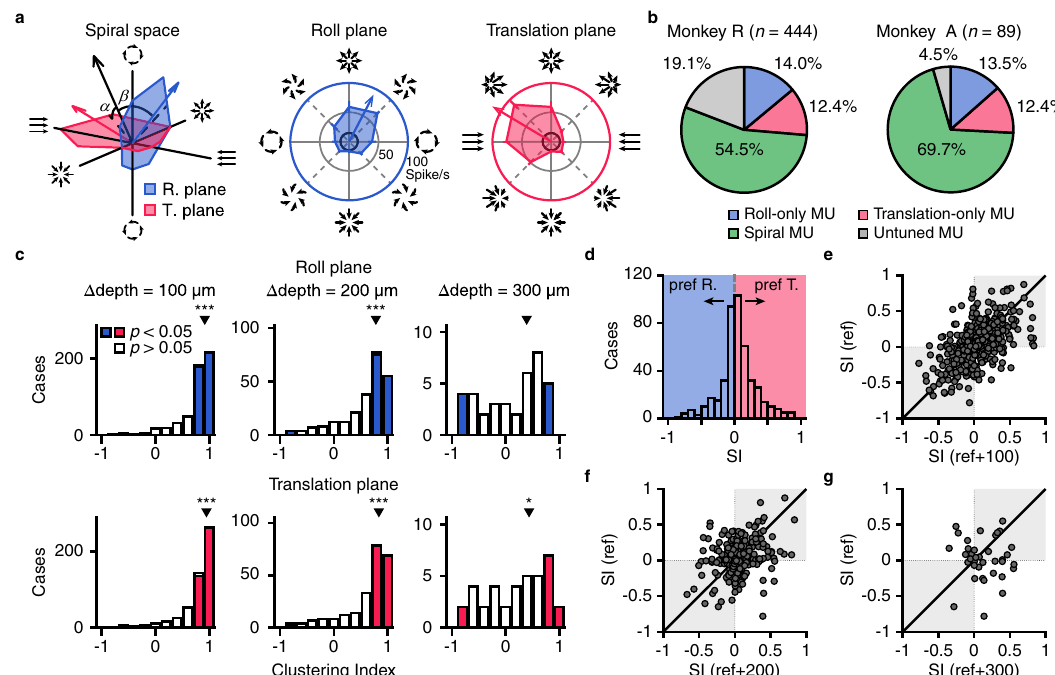
Fig. 3 | Tuning properties ofMSTd MUs. a PolarplotoftuningforanexampleMU inthe3Dspiralspace(left),rollplane(middle)andtranslationplane(right).Basedon vector sum of MU activity, the black arrow in the 3D spiral space, blue arrow in the roll plane and red arrow in the translation plane represent residual vector and indicate the preferred direction, respectively. α and β in spiral space represent the angle between the residual vector and the roll plane and translation plane, respec- tively. Polar angle, the rotation component or translation component; Radius, fi ring rate; Thick black circles, spontaneous fi ring rate; R. plane, roll plane; T. plane, translation plane. b Proportion of different cell types of MSTd for monkey R and monkey A. c Distributions of clustering index of roll (up) and translation (bottom)